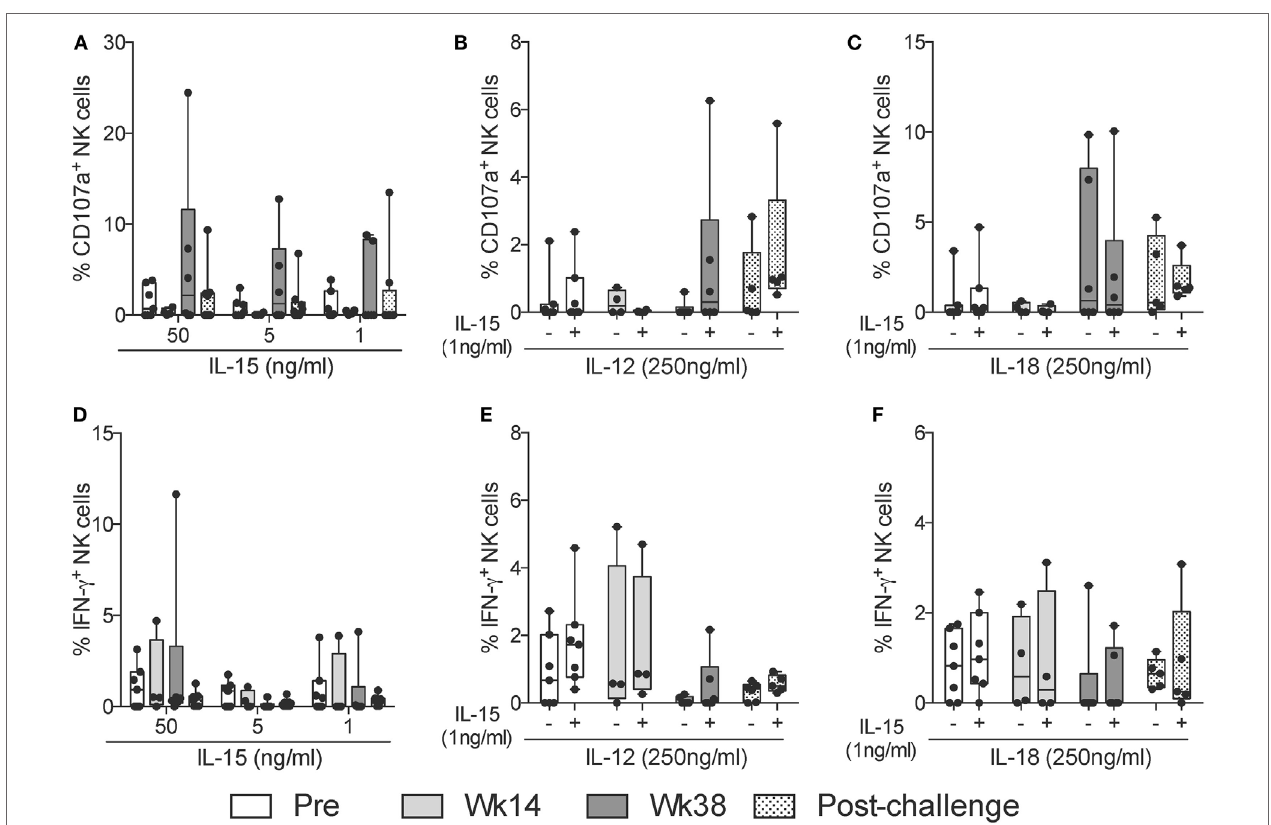
FigUre 6 | nK cell cytokine-dependent responses through vaccination and after siV infection . Frozen PBMCs obtained over the course of vaccination and challenge were thawed and stimulated overnight in the presence of different concentrations and combinations of IL-15, IL-12, and IL-18. (a–F) Expression of CD107a (top row) or IFN- γ (bottom row) by total NK cells in response to high (50 ng/ml) and low (5 ng/ml) concentrations of IL-15 (a,D) ; a high (250 ng/ml) dose of IL-12 in the presence ( + ) or absence ( − ) of a low (5 ng/ml) dose of IL-15 (B,e) ; and a high (250 ng/ml) dose of IL-18 in the presence ( + ) or absence ( − ) of a low (5 ng/ml) dose of IL-15 (c,F) . Values of non-stimulated samples and negative controls have been subtracted. Data are shown as minimum to maximum boxes with all data points